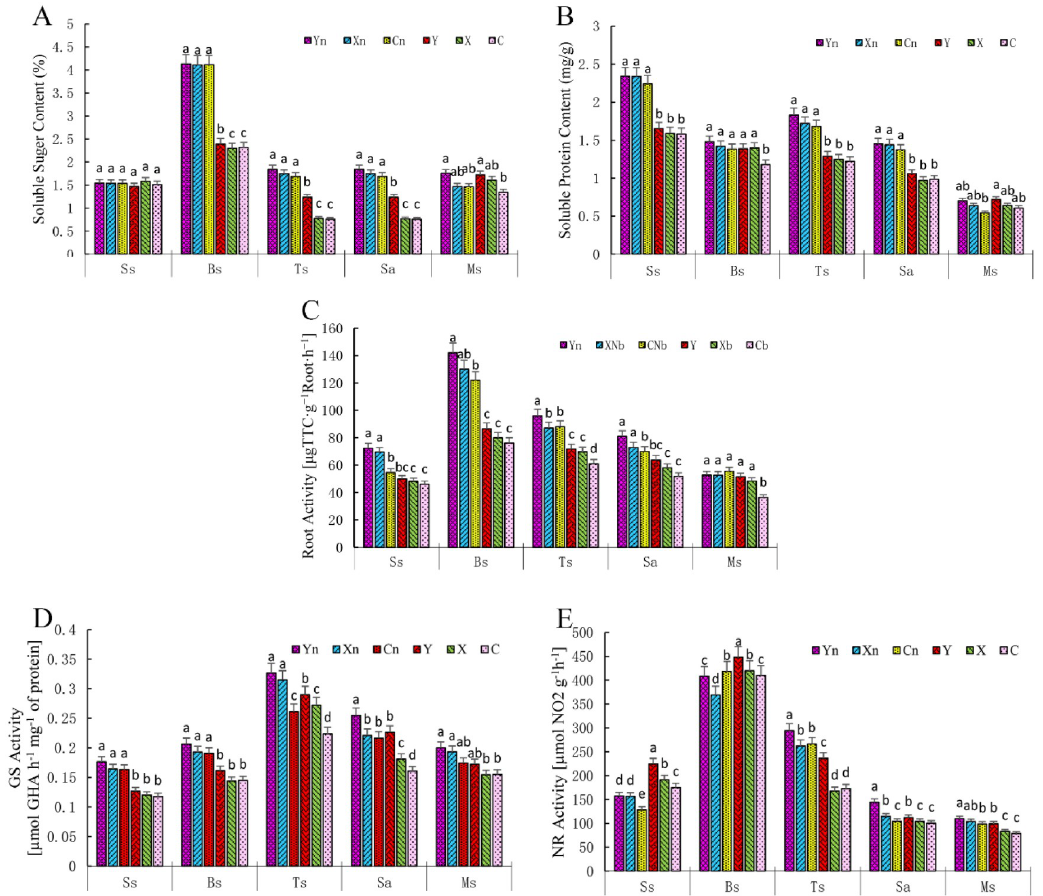
Fig 3. Influence of N-deficiency fertilization on potato quality and enzyme activity. (A), Soluble sugar content; (B), soluble protein content; (C), root activity; (D), NR activity; (E), GS activity. NR, nitrate reductase; GS, glutamine synthetase. Ss, Bs, Ts, Sa and Ms indicates the seedling, bud, tuber bulking, starch accumulation and mature stage, respectively. For statistical analysis, n = 3, two-way ANOVA test followed by Tukey post-hoc. Different letters indicate that mean values are significantly different (p < 0.05). Y, X and C indicate the cultivar of “Yanshu 4”, “Xiabodi” and “Chunshu 4”, respectively. N means treatment with N containing fertilizer (control). For example, YN and Y means “Yanshu 4” treated with N-containing and N-deficiency fertilizer,